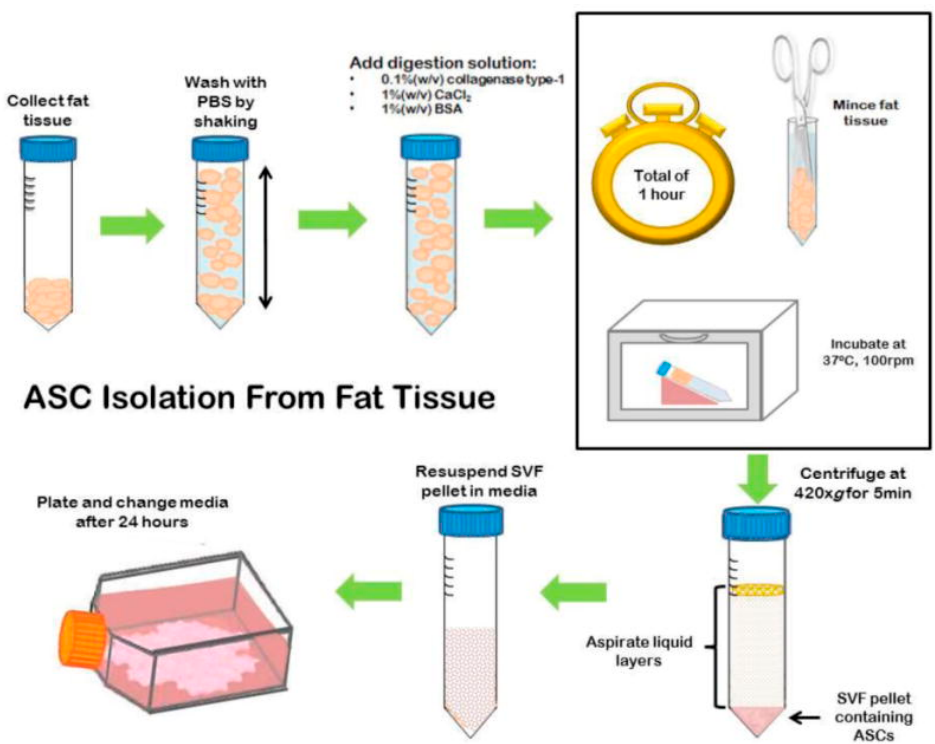
Figure 6. A representative schematic of ASCs isolation from fat tissue after digestion, isolation of stromal vascular fraction (SVF), and plating of SVF. Reproduced with permission from Reference [198] .